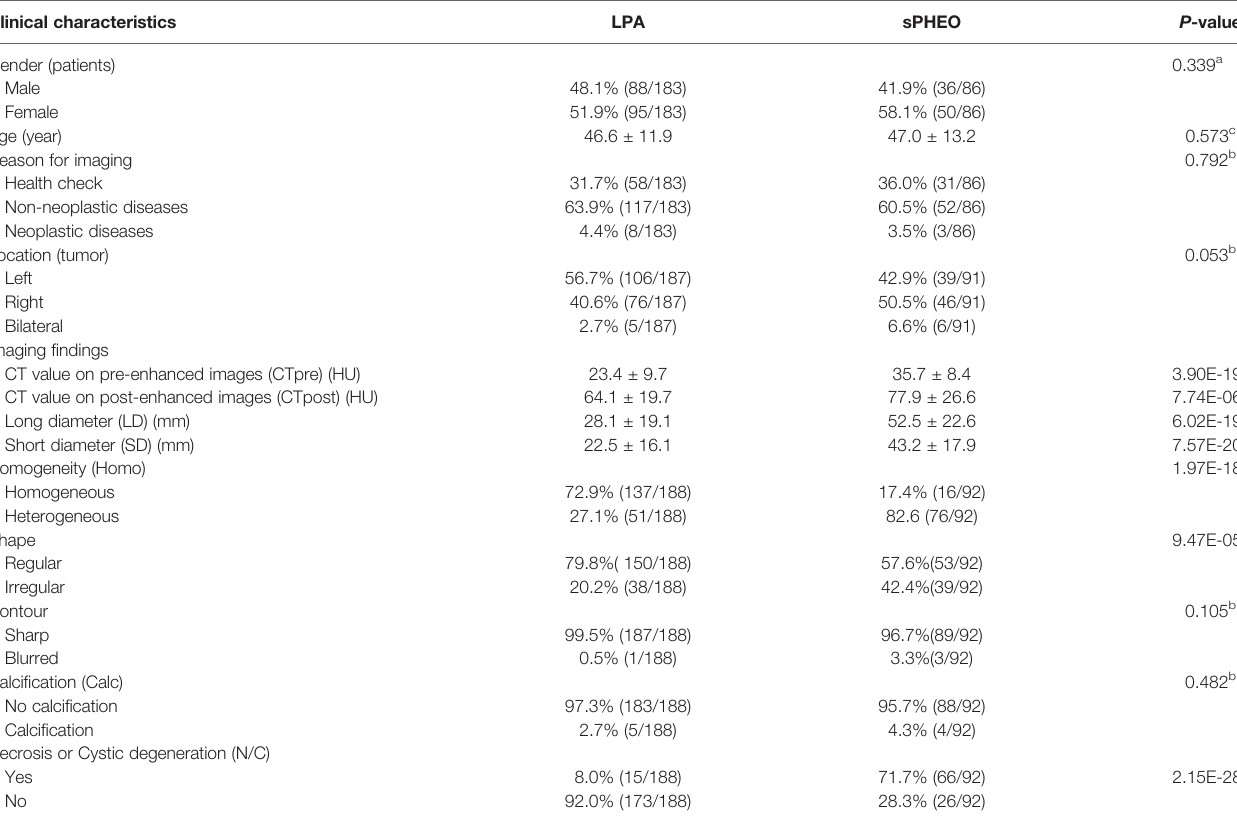
TABLE 1 | Clinical and radiological characteristics of subclinical pheochromocytoma (sPHEO) and lipid-poor adenomas (LPA). Clinical